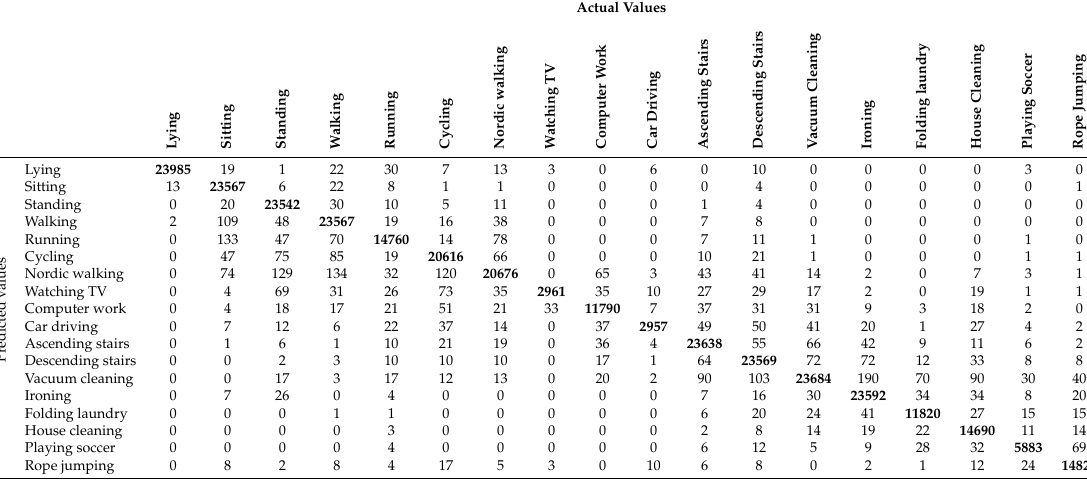
Table 12. Confusion matrix of the AHN classifier using the first 30 s of each activity carried out by all subjects.